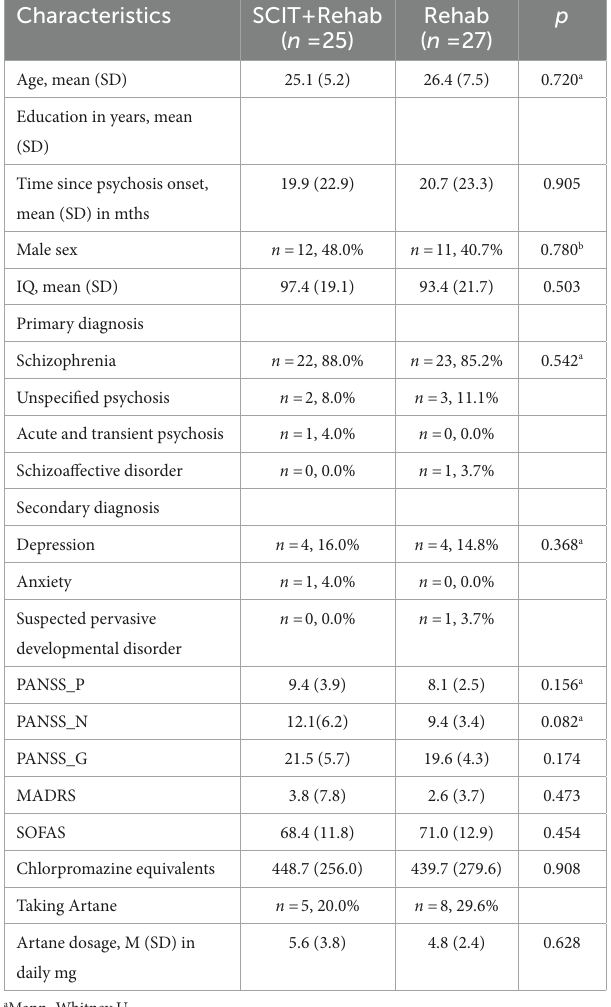
TABLE 1 Demographic and clinical characteristics at T1 ( N = 52).